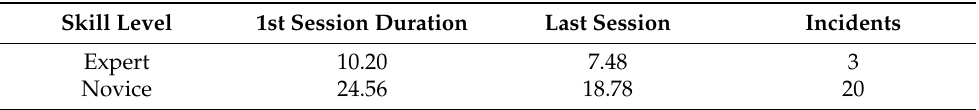
Table 3. Average times taken to complete the task with the dominant and non-dominant hand in the first and last of ten sessions per hand. The total number of incidents across all sessions are shown in the last